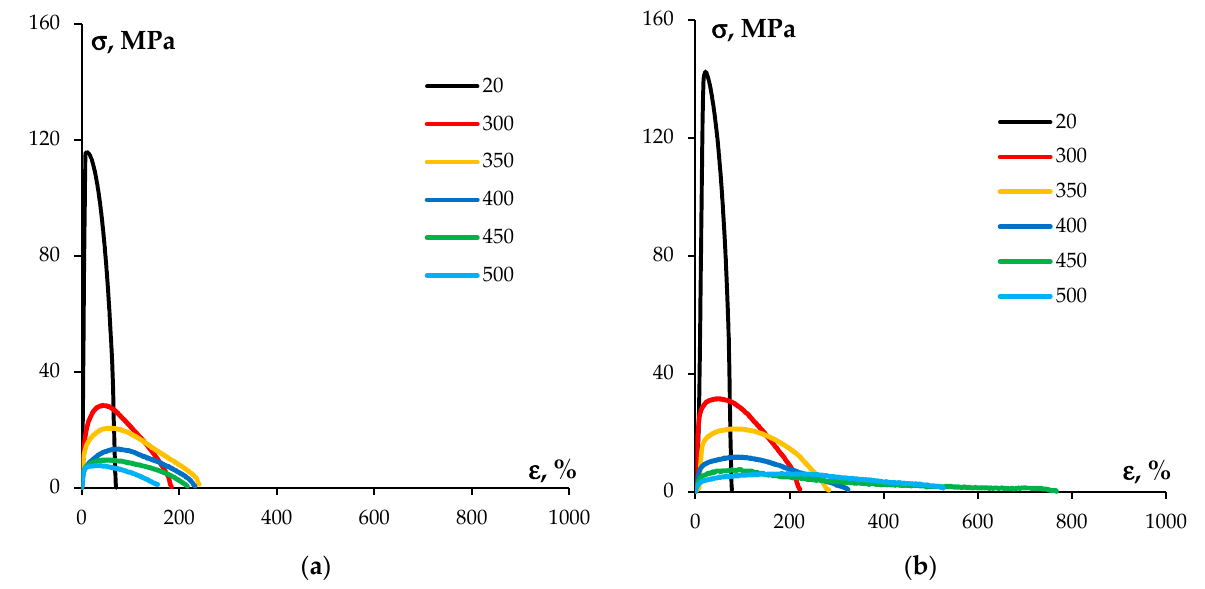
Figure 4. σ ( ε ) curves in UFG alloys: series Nos. 1 ( a ) and 5 ( b ). Tests at elevated temperatures (°C) and a strain rate of 3.3 × 10 − 3 s − 1 .